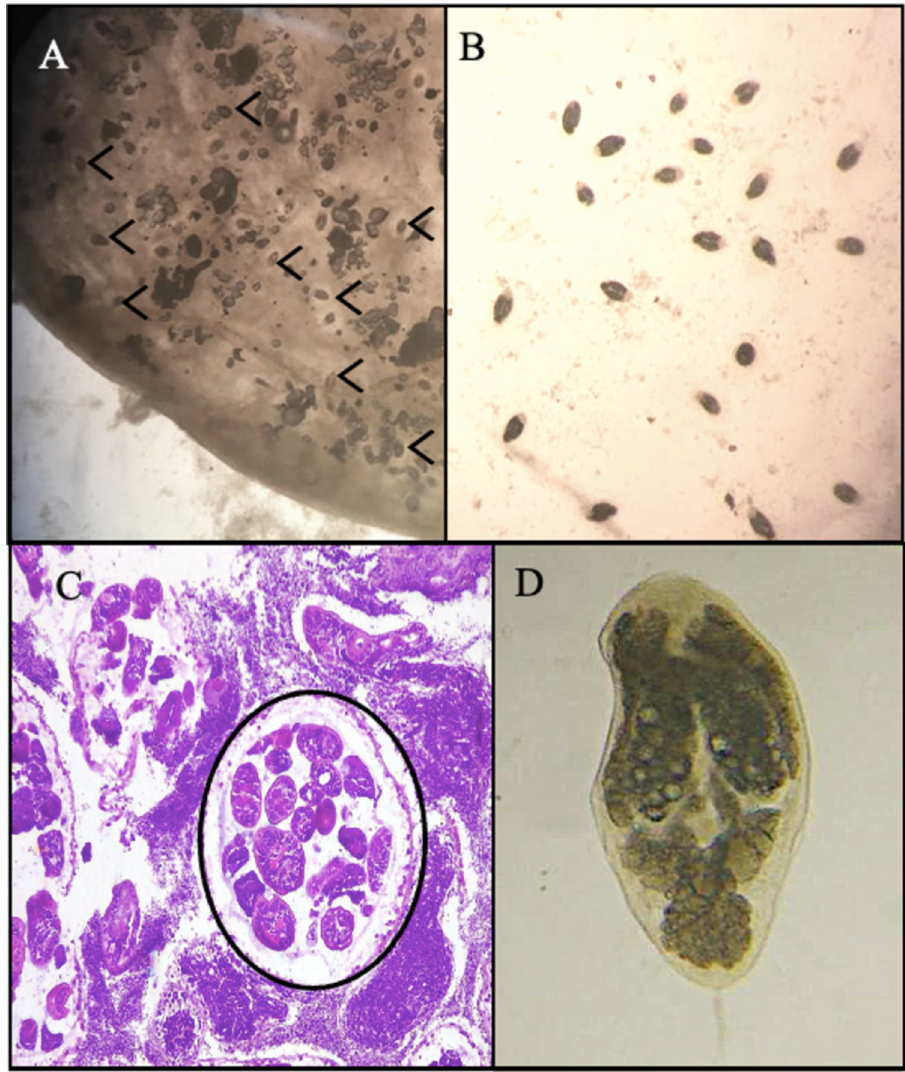
Fig 4. Parasites belong to the family Gymnophallidae collected from the clam A . antiqua . (A). Mantle tissue parasitized by the state of metacercariae observed with stereoscopic microscope at 1.5X. (B). Parasites recovered from the gonad tissue observed at 2.0X. (C). Photomicrograph of a gonadal section of a male with a high degree of parasitism, the indicated area shows segments of parasites located within one of the gonadal tubules. (D). Individual of Gymnophallid digenean observed with 40X (scale bar 40 μ